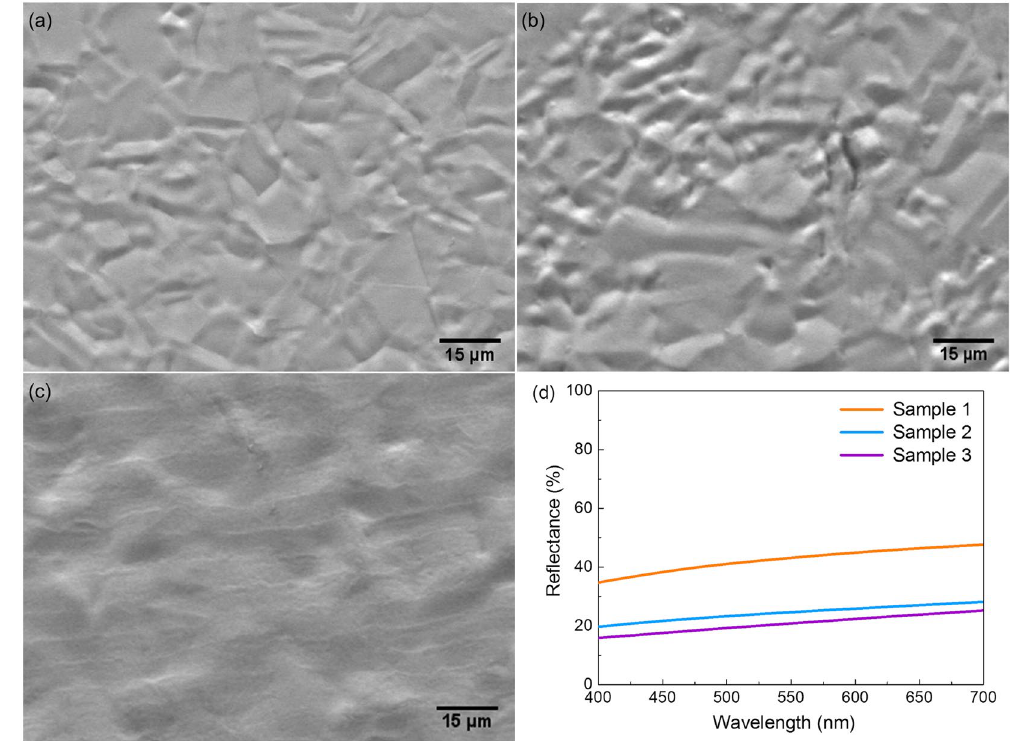
Figure 3. Morphologies of laser marking and the simulation results of reflectance. ( a )~( c ) SEM images of sample 1~3, respectively. ( d ) Simulation results of optical